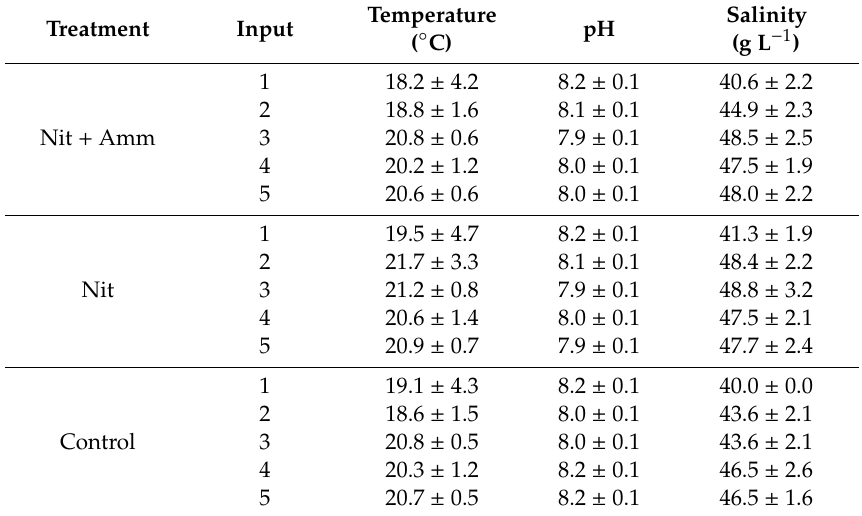
Table 1. Recirculating aquaculture system (RAS) physicochemical parameters measured for the e ffl